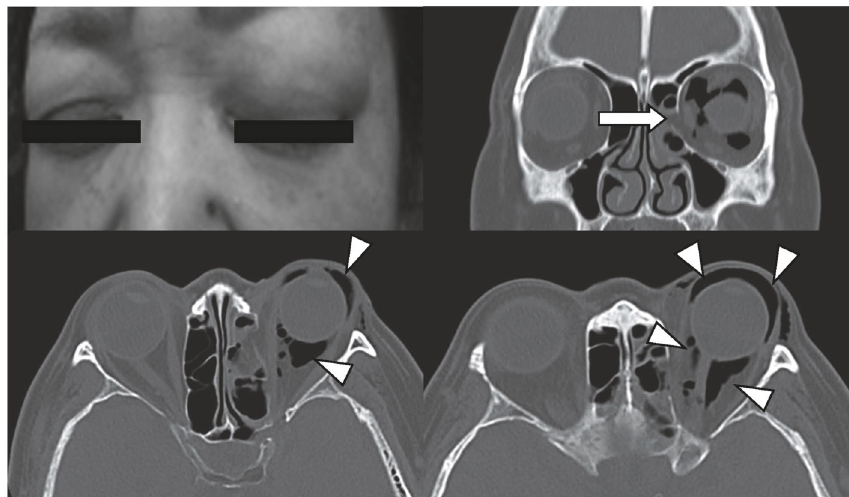
Figure 1: Nontender left periorbital swelling is noted (upper left panel). Computed tomography showed blowout fracture of the left orbital floor with orbital fat herniation (white arrow). Periorbital and orbital emphysema is noted (white